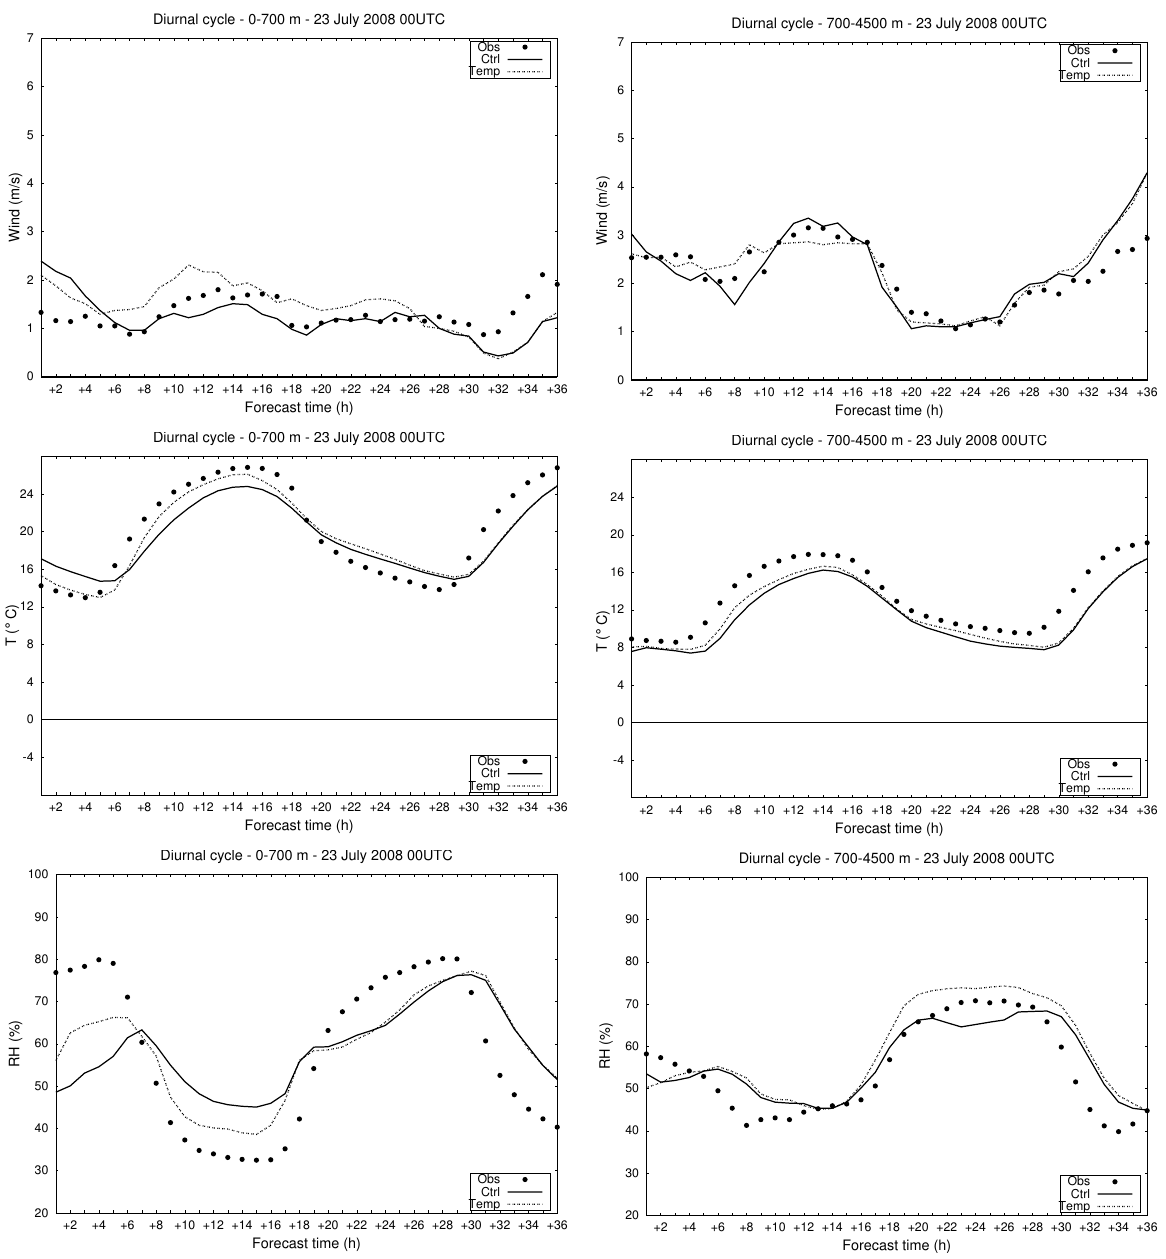
Fig. 12. Diurnal cycle for the July 2008 case, over the plains (left) and over the mountains (right); wind intensity (upper panels), temperature (middle panels) and relative humidity (bottom panels). The dots represent the Ctrl run and the dotted line represents the Temp run.